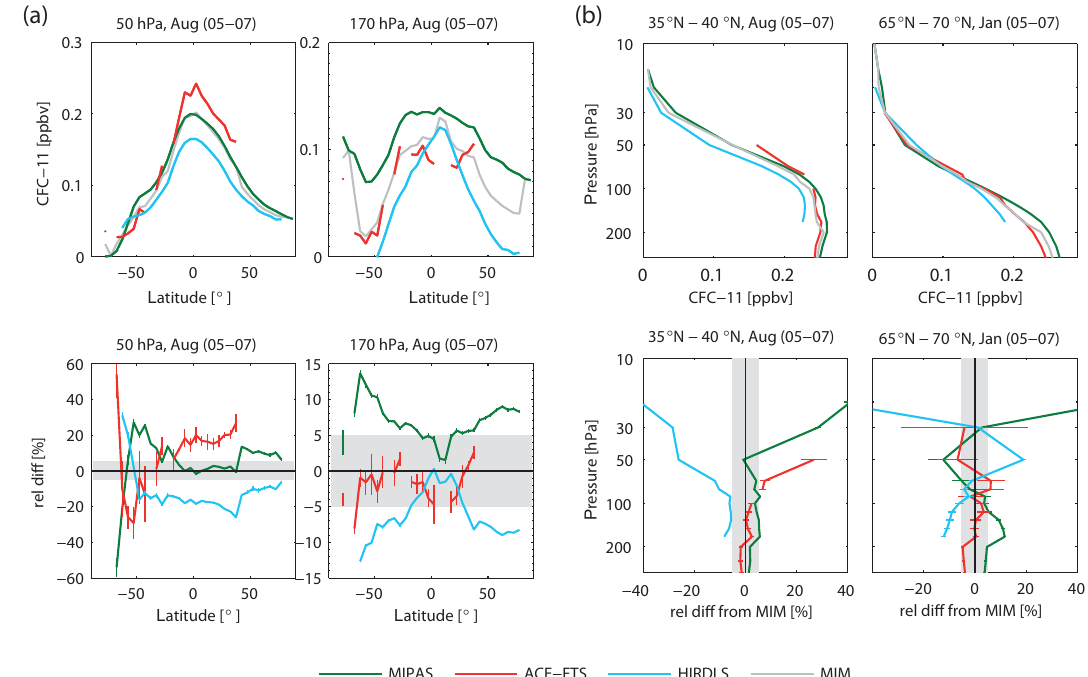
Figure 2. Meridional monthly zonal mean CFC-11 profiles at 50 and 170hPa for August 2005–2007 (upper row) and relative differences between the individual instruments and the MIM profiles (lower row) are shown in panel (a) . Vertical monthly zonal mean CFC-11 profiles for 35–40 ◦ N in August and 65–70 ◦ N in January 2005–2007 (upper row) and relative differences between the individual instruments and the MIM profiles (lower row) are shown in panel (b) . The grey shading indicates the ± 5% difference range. Bars indicate the uncertainties in the relative